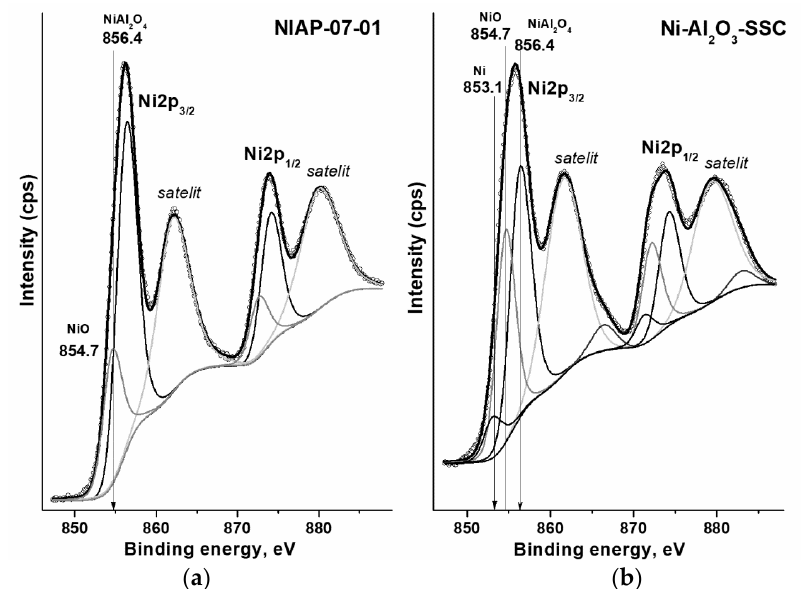
Figure 9. Deconvoluted high-resolution XPS spectra of Ni2p for ( a ) NIAP-07-01 and ( b ) Ni-Al 2 O 3 -SSC catalysts.